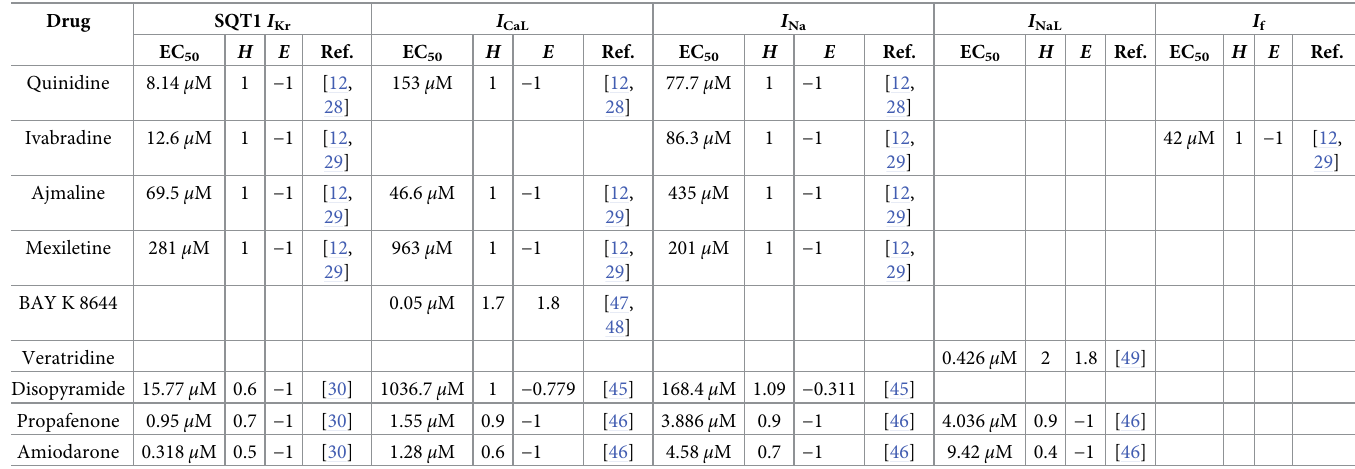
Table 1. Drug characteristics.